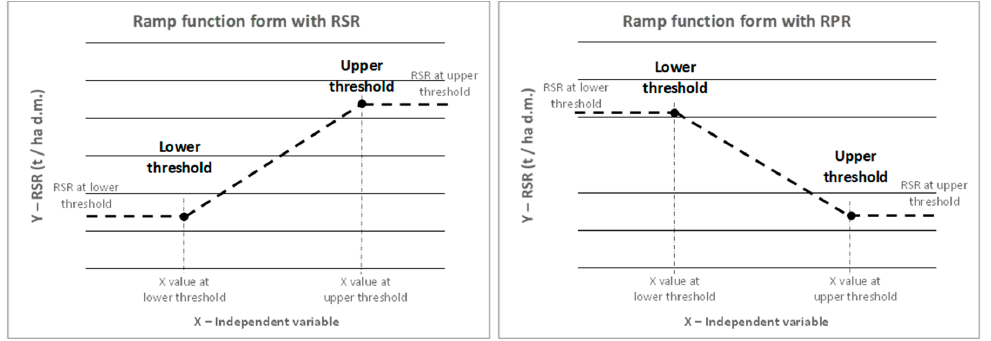
Figure 1. Ramp function utilized for adapting the mathematical expressions found in the regression analysis with RSR ( left ) and RPR ( right ) as dependent variable. RSR: Residue to surface ratio; RPR: Residue to product ratio.